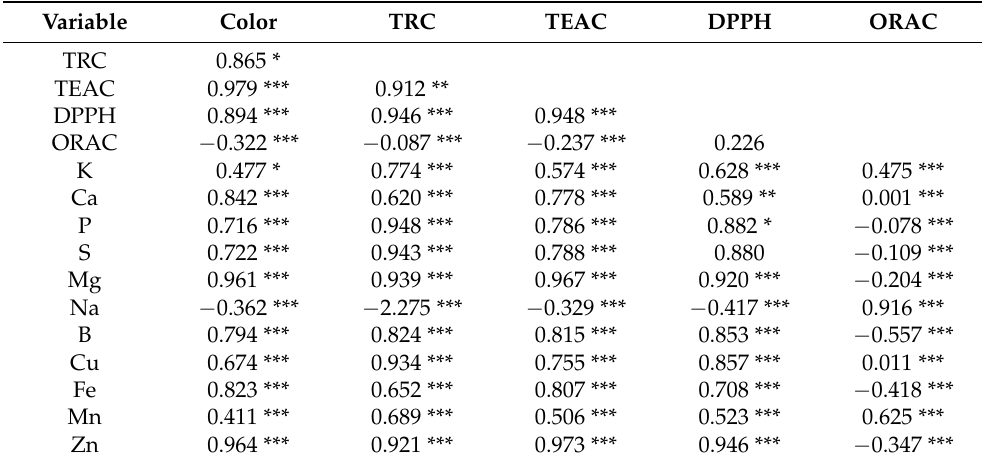
Table 6. Correlation matrix (Pearson’s correlation coefficients) of color, antioxidant and multielement parameters in Hungarian honeys.